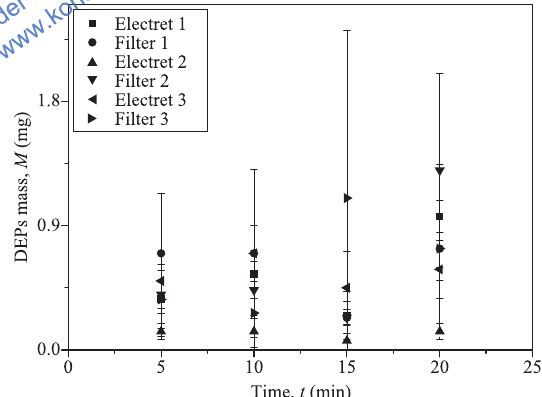
Fig. 8 Mass of DEPs that penetrated fibrous filters in the 5 th , 10 th , 15 th and 20 th minute of the test. The symbols rep- resent the mean values and error bars represent the standard deviations.